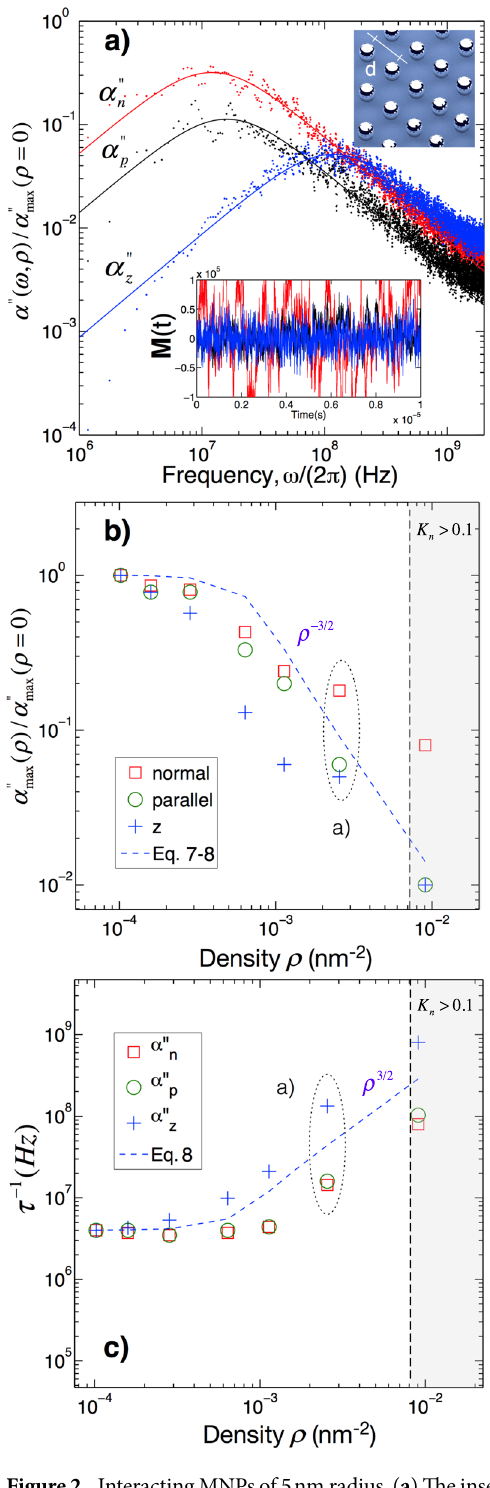
Figure 2. Interacting MNPs of 5 nm radius. ( a ) The inset illustrates the center-to-center inter-particle distance d. Imaginary part of the magnetic susceptibility α ′′ ( ω , ρ ) for ρ = 2.5 · 10 − 3 nm − 2 normalized by its maximum for noninteracting MNPs. The magnetic relaxation along the cross-plane direction α ″ ( ) is weaker and faster than z those of the in-plane components α α ″ ″ ( ) , . The spectra obtained from a single equilibrium simulation (points) n p are fitted with a Debye function (solid lines). ( b , c ) Evolution of the susceptibilities α ″ as a function of the MNP n pz , , density. Dipole-dipole interactions diminish the absorption amplitude ( b ) and increase the frequency of maximum of dissipation ( c ). This effect is further enhanced along the cross-plane direction α ″ ( ) while an in-plane component z α ″ ( ) is always more affected by the interactions than the other α ″ ( ) . The grey region indicates concentrations n p where hydrodynamics effects may occur due to small inter-particle distances defining a larger Knudsen